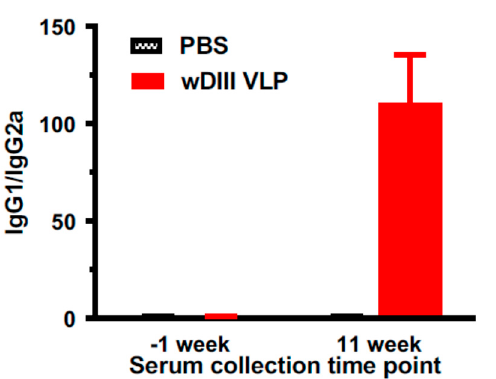
Figure 6. Anti-wDIII IgG subtypes elicited by immunization with HBcAg-wDIII VLPs. Sera collected at week − 1 (before immunization) and week 11 from mice injected with HBcAg-wDIII VLP or PBS were measured for wDIII-specific IgG1 and IgG2a. The mean IgG1/IgG2a ratio and SD from three independent measurements were calculated for each mouse group.